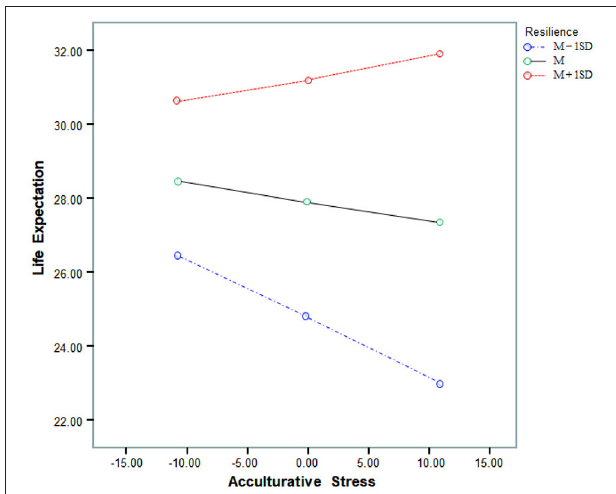
FIGURE 2 | Interaction effect of acculturative stress and resilience on life